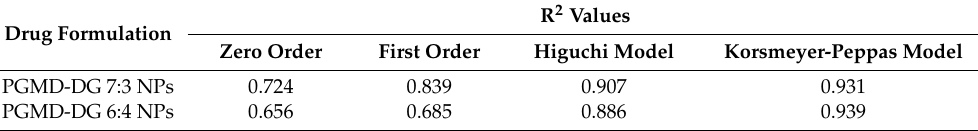
Table4. Representsencapsulationanddrugloadinge ffi ciencyofdiosgeninloadedPGMDnanoparticles. Drug